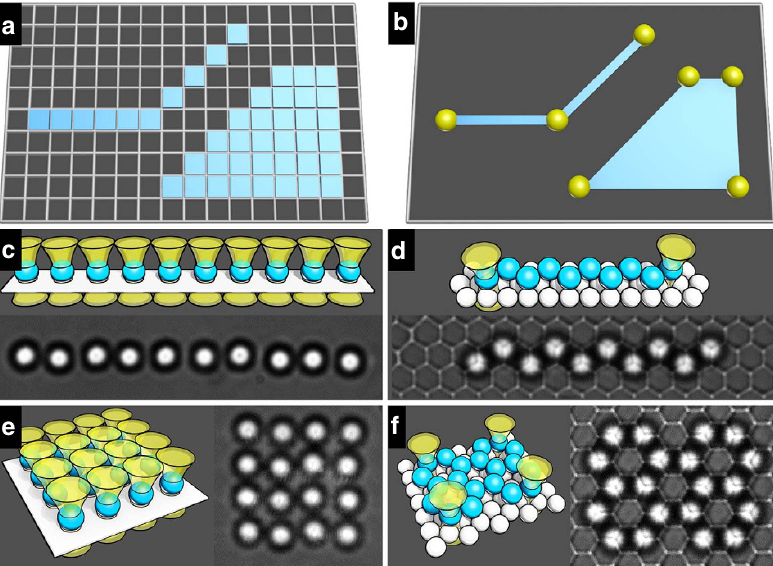
Figure 1 | The raster/vector concept in computer graphics and assembly. ( a ) Raster graphics made of pixels. ( b ) Vector graphics highlighting pin points. ( c , e ) Raster assembly of particles, as directed by optical tweezers, on a flat substrate into a straight chain and a square. The assembly information is encoded in 10 and 16 optical tweezers, respectively. ( d , f ) Vector assembly of particles, as directed by optical tweezers, on a colloidal monolayer into a zigzag chain and a perylene-like structure. The assembly information is concentrated into 2 and 4 optical tweezers, respectively. In the schematic illustrations, yellow funnels represent optical tweezers, blue spheres are top particles and white spheres are bottom particles that form the monolayer substrate beforehand. In the optical microscopy images, the spheres are 3.4 m m in